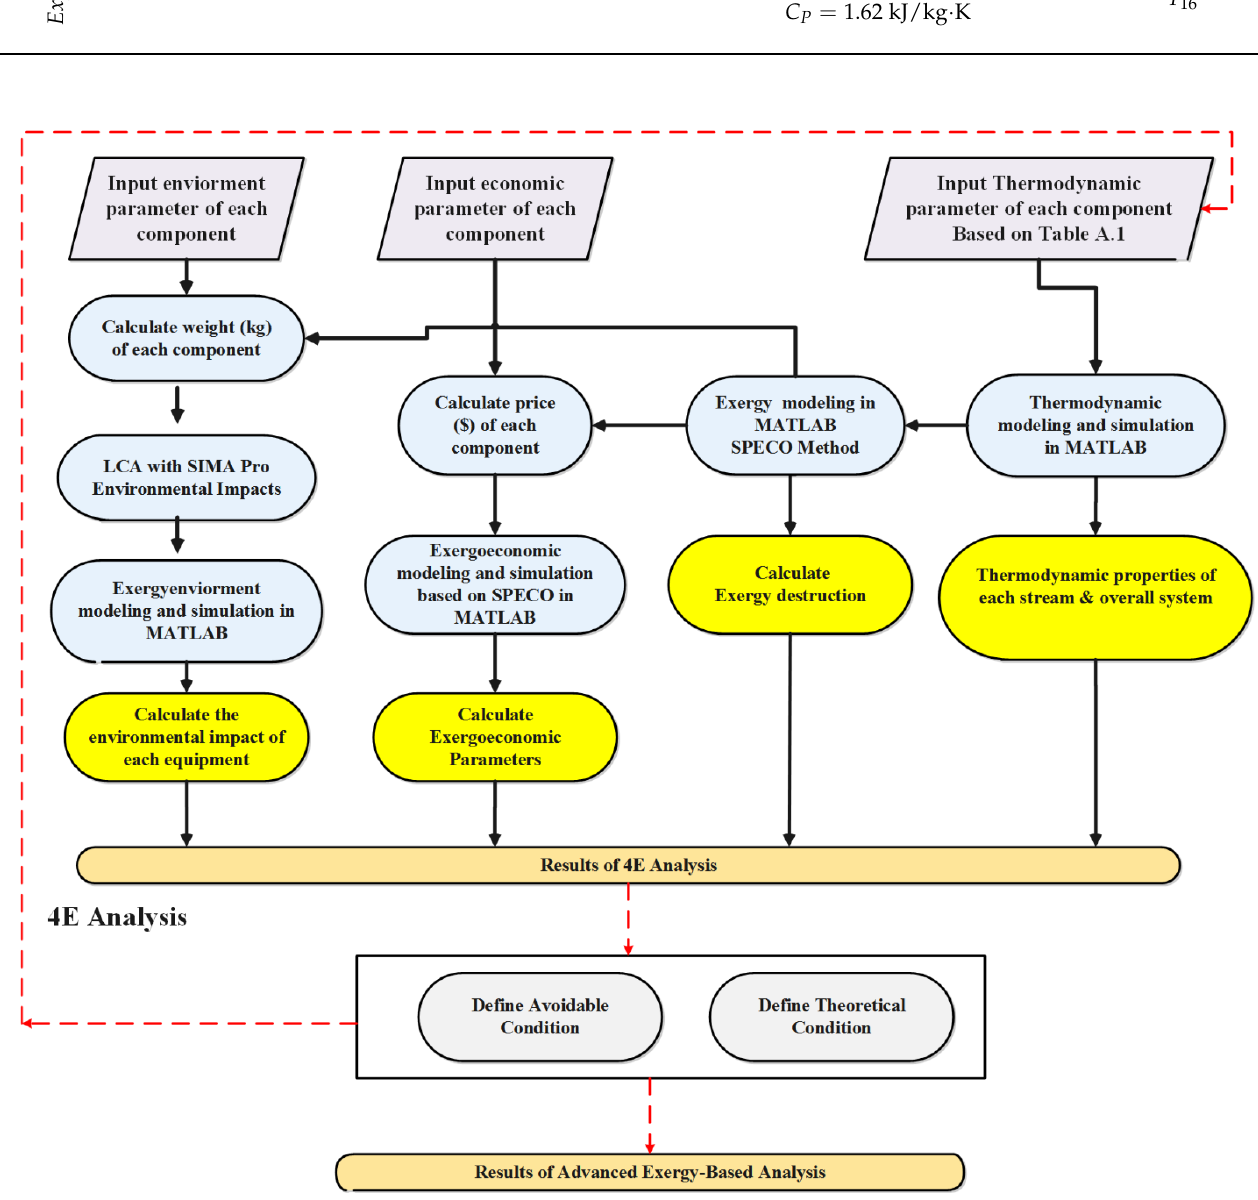
Figure A1. Schematic of computational procedure for 4E and advanced exergy-based analyses. Table A2. Exergy destruction and exergy efficiency formulation [17].